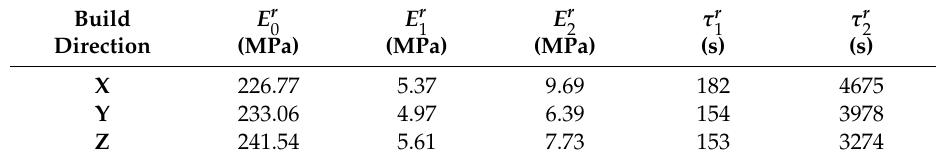
Table 1. Parameters describing the stress relaxation curves for the three types of Alumide specimen.